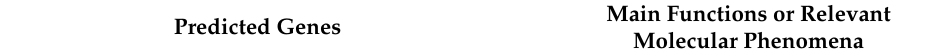
Main Functions or Relevant Molecular